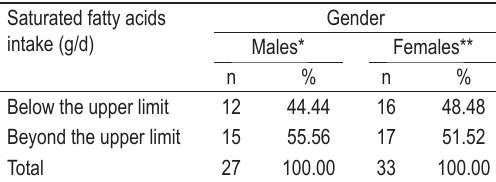
FIGURE 4. Link between BMI and SFAs intake in female